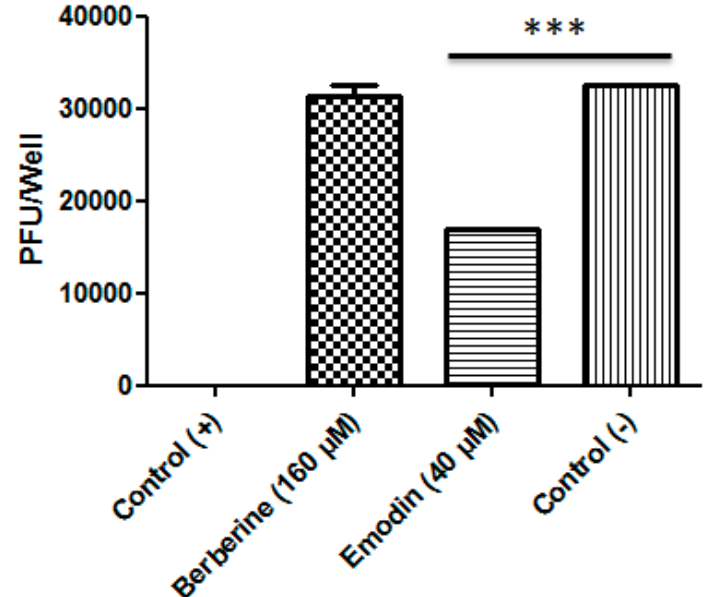
Figure 3. Pre-treatment of cells with emodin and berberine. Graphic of relative foci number after treatment of Vero E6 cells with berberine or emodin. Cells treated with drug diluent were used as negative control. Results are the means (±SD) from three independent experiments and are expressed as relative values compared to untreated cells. *** p < 0.0001 vs. control.